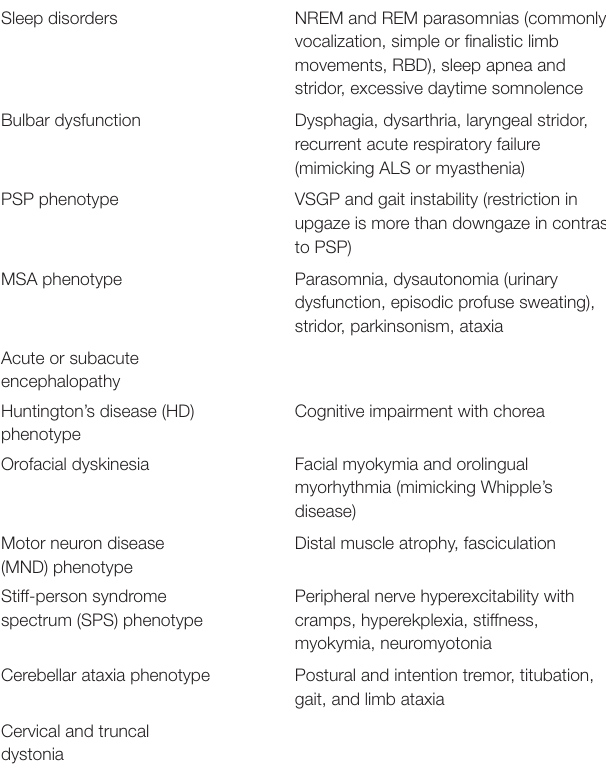
TABLE 4 | Phenotypic presentations (chameleons) of IgLON5 disease. Sleep